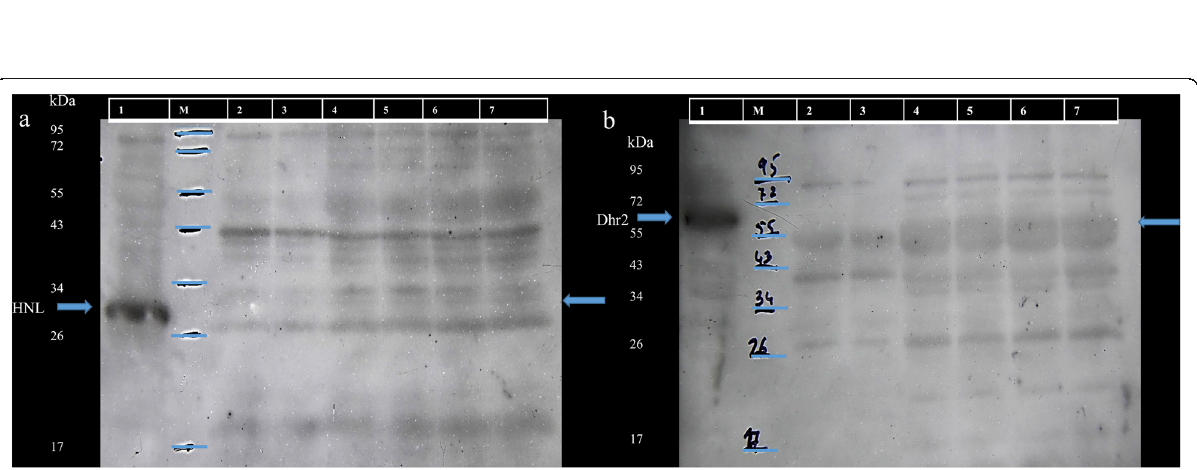
Fig. 7 Western Blot analysis of transiently expressed proteins. a Western blotting with polyclonal antibody against MeHNL protein, lane 1: total protein from M. esculanta as positive control, lane 2: cotton as negative control, lane 3: TRV1: TRV2 infiltrated cotton as negative control, lanes 4 ~ 7: cotton samples as positive (co-expressing MeHNL & SbDhr2 proteins) samples. b Western blotting with polyclonal antibody against SbDhr2 protein, lane 1: total protein from S. bicolor as positive control, lane 2: cotton as negative control, lane 3: TRV1 + TRV2 infiltrated cotton as negative control, lanes 4 ~ 7: cotton samples as positive (co-expressing MeHNL & SbDhr2 proteins) samples. Bands of our interest are highlighted; M: protein